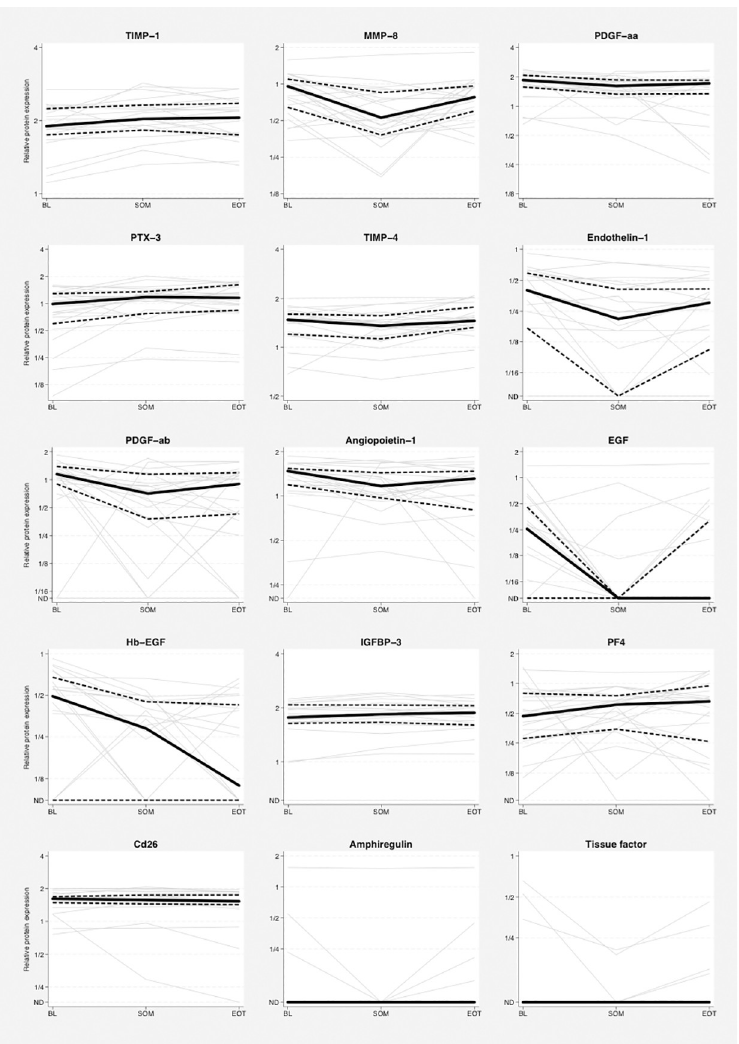
Fig 2. Proteins with evidence for changes in serial analysis (n=22 patients). Dynamics of log protein levels for the 15 proteins with nominal p-values < 0.05 for change either from BL to SOM or from SOM to EOT. Faded grey lines connect relative protein levels for each patient. Black solid lines represent median values and dotted lines indicate upper and lower quartiles. Relative protein levels below the detection limit were set to 50% of the lowest registered value for each protein, respectively, and the corresponding label on the y-axis has been set to ND (Not Detected). Note that the lower quartile will be ND if at least 25% of the patients have values below the detection limit, the median will be ND if at least 50% of the patients have values below detection limit and that the upper quartile will be ND if at least 75% of the patients have undetectable levels of a protein. BL, baseline; SOM, start of maintenance treatment; EOT, end of